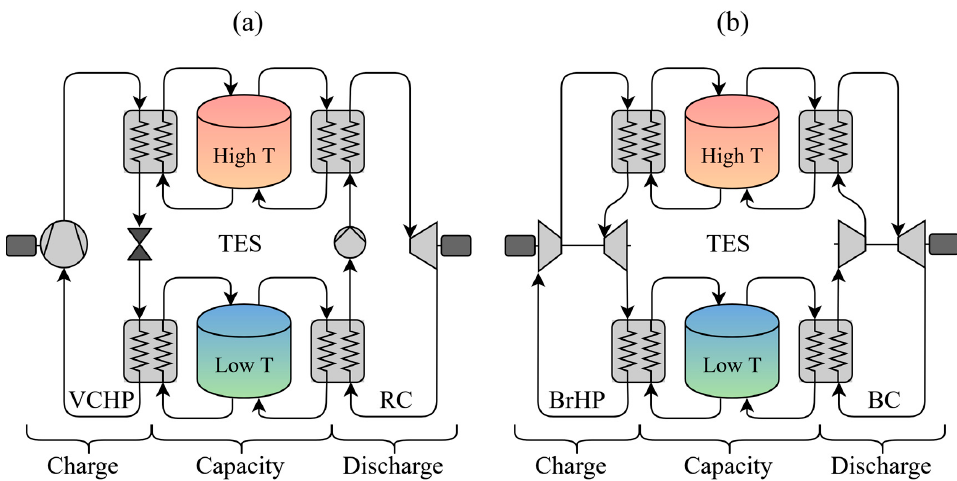
Figure 2. PTES system schematic. ( a ) Rankine PTES; RC stands for Rankine Cycle. ( b ) Brayton PTES; BrHP denotes a Brayton-based HP, whereas BC stands for Brayton Cycle. The systems are represented with sensible TES, but other technologies can be used. Refer to [14] for further details.